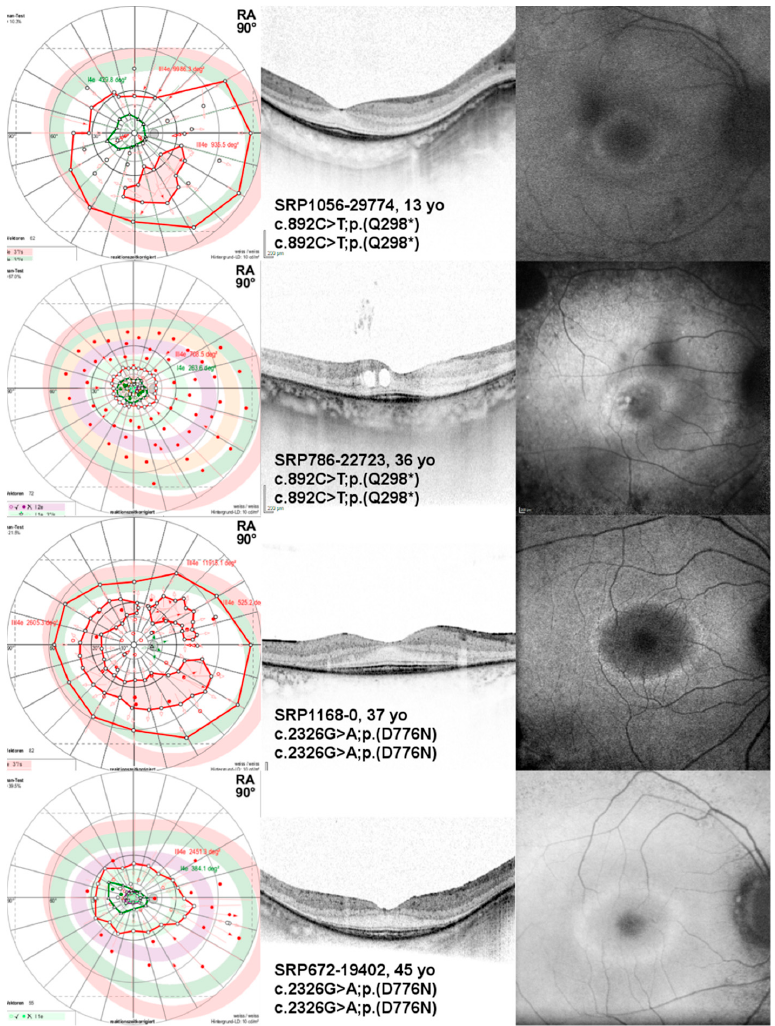
Figure 3. Kinetic visual field (VF), optical coherence tomography (OCT), and fundus autofluorescence (FAF) images of the right eyes of patients with PDE6B -associated retinitis pigmentosa harboring the variant c.892C>T;p.(Q298*) or variant c.2326G>A;p.(D776N) in a homozygous state. Note the difference in VFs despite the age of the patients. Additionally, note the thinning of the outer retinal layers outside the center of the OCT imaging, which is typical for retinitis pigmentosa (RP). Patient SRP786-22723 additionally exhibits cystoid macular edema. Note the parafoveal hyperautofluorescent ring on FAF imaging for all patients.